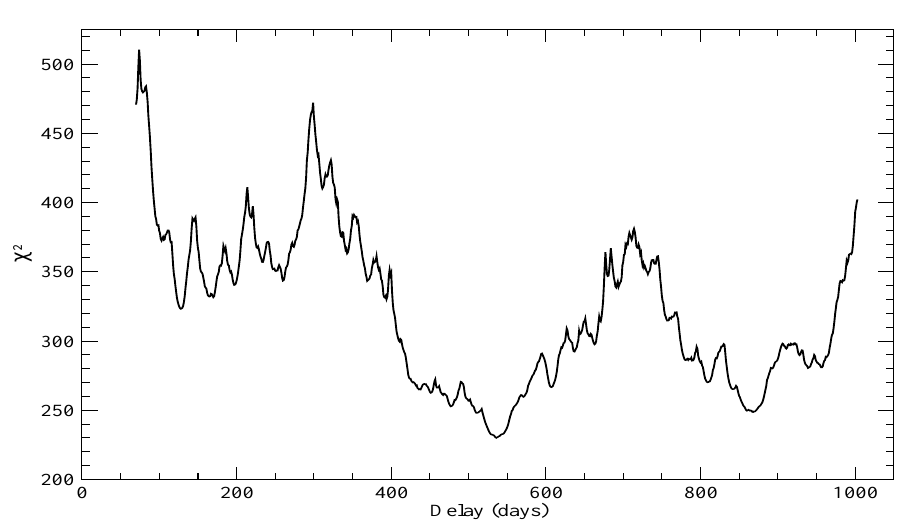
Fig. 1. The (cid:31) 2 curve of the PRH method applied to the Vanderriest et al. (1989) data. Delay estimate (cid:28) AB = 536 days.